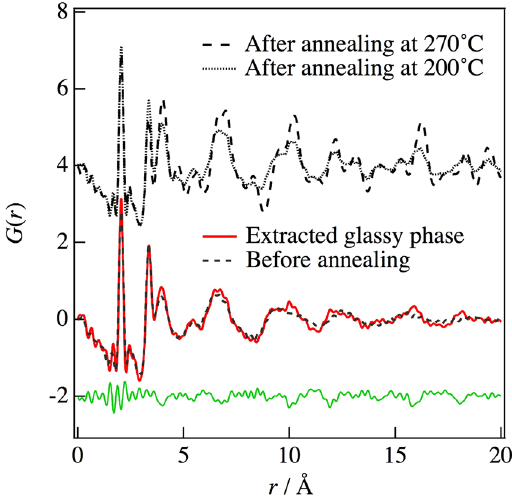
Figure 4. Comparison between the PDFs determined by equation (3) using the differential pair distribution functions: upper dashed line, after annealing at 270 °C; dotted line, after annealing at 200 °C; lower dashed line, before annealing; red solid line, glassy phase extracted for annealing at 200 °C.